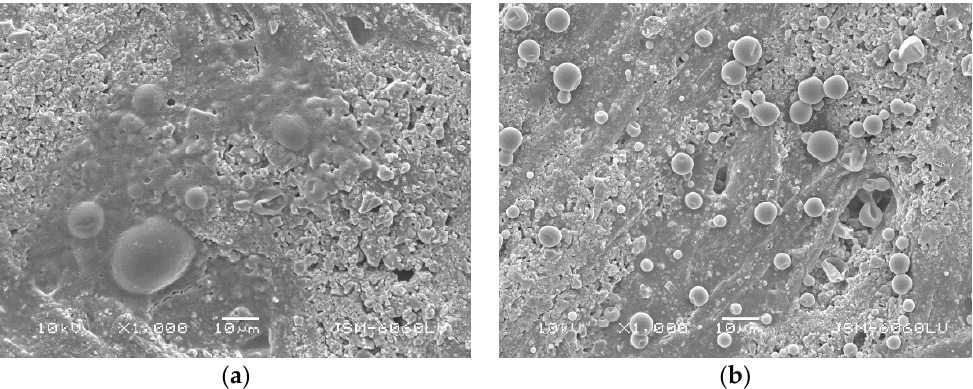
Figure 7. Paper coated with a formulation containing microcapsules (2 g/m 2 ): ( a ) coacervation microcapsules (SEM, 1000 × ); ( b ) in situ polymerization microcapsules (SEM, 1000 × ).